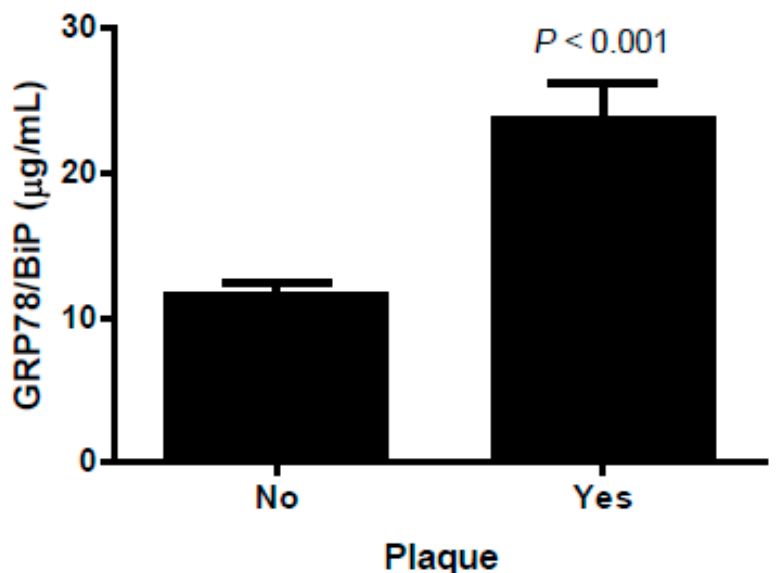
Figure 2. Circulating 78 kDa glucose-regulated protein / binding immunoglobulin protein (GRP78 / BiP) levels according to the presence of atherosclerotic plaques. The results are expressed as the mean ± SEM. p values for group comparison are reported for the age- and gender-adjusted ANCOVA test.